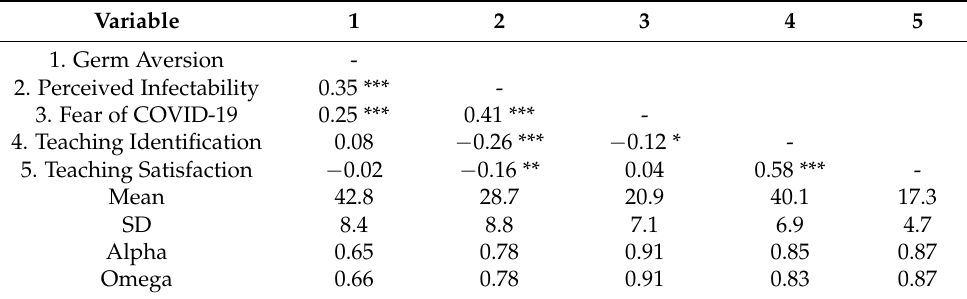
Table 1. Descriptive statistics, intercorrelations and reliabilities for the study